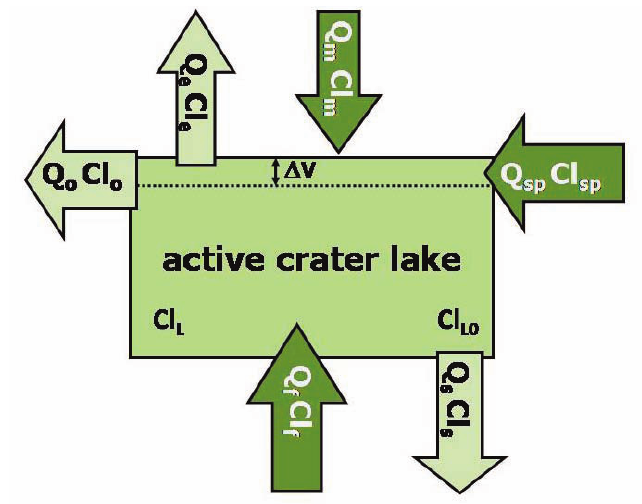
Figure 6. Box model for the chlorine budget, observed for a period of time t to 0